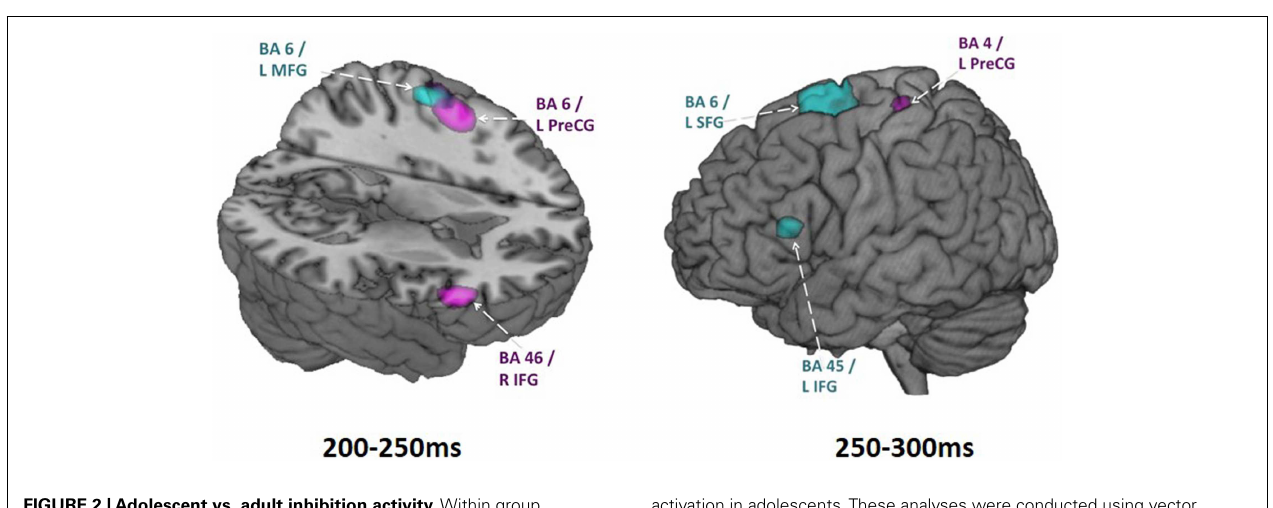
FIGURE 2 |Adolescent vs. adult inhibition activity. Within group activations overlaid on brain images for time windows from 200 to 250ms (on the left) and 250 to 300ms (on the right). Inhibition condition > baseline condition, in adults is shown in magenta ( p < 0.005, uncorr.) and in adolescents shown in blue ( p < 0.005, uncorr.). Note particularly the earlier right IFG activation in adults and the later left IFG